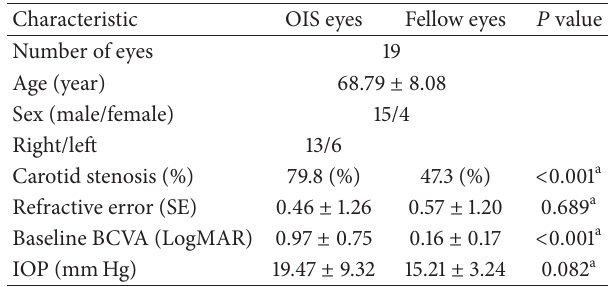
Table 2: Subfoveal choroidal thickness and choroidal volume in unilateral ocular ischemic